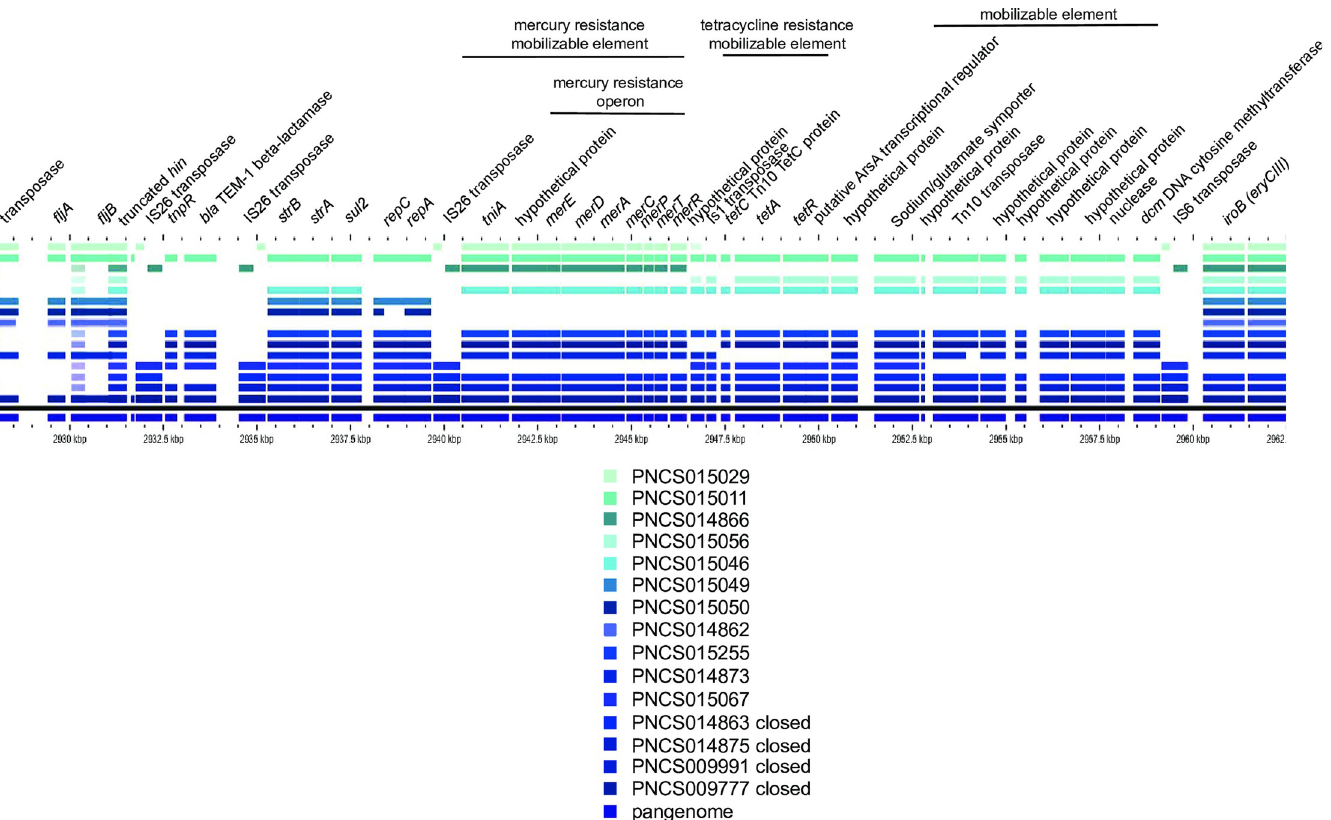
Fig 2. Identification and structure of mobilizable elements showing heterogeneity within the MREL. Both draft and closed genomes were used to create the diagram. The comparison was done using GView Server with the “pangenome analysis” settings and the figure was annotated in Adobe Illustrator CS6. This analysis uses BLAST searches to align genes to a reference genome, in this case isolate PNCS009777. Note that the tetA designation is used throughout to describe the gene encoding the class B tetracycline determinant tet(B). Not all loci defined by Lucarelli and colleagues [31] are